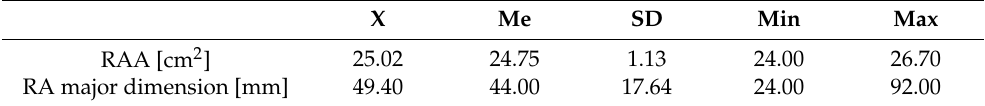
Table 3. Right ventricular echocardiography parameters in the study